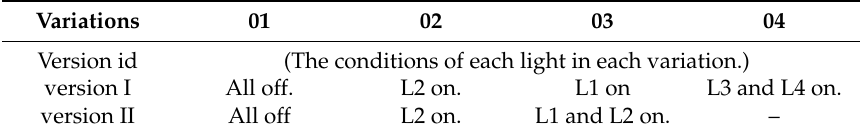
Table 2. The illumination variations for Extended-Multi-Dim database. The L represents the lamp in Figure 2, and there are four and three illumination variations in version I and Version II,